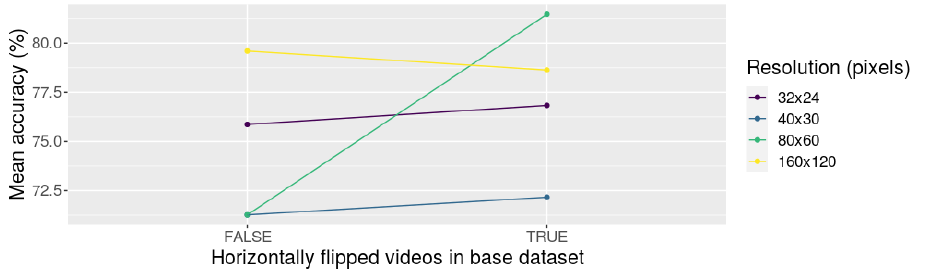
Figure 10. Interaction plot of depth (10, 30, and 90 frames) and resolution (32 × 24, 40 × 30, 80 × 60, and 160 × 120 pixels) using the accuracy values obtained from experiment P04 (using 70% of the dataset for